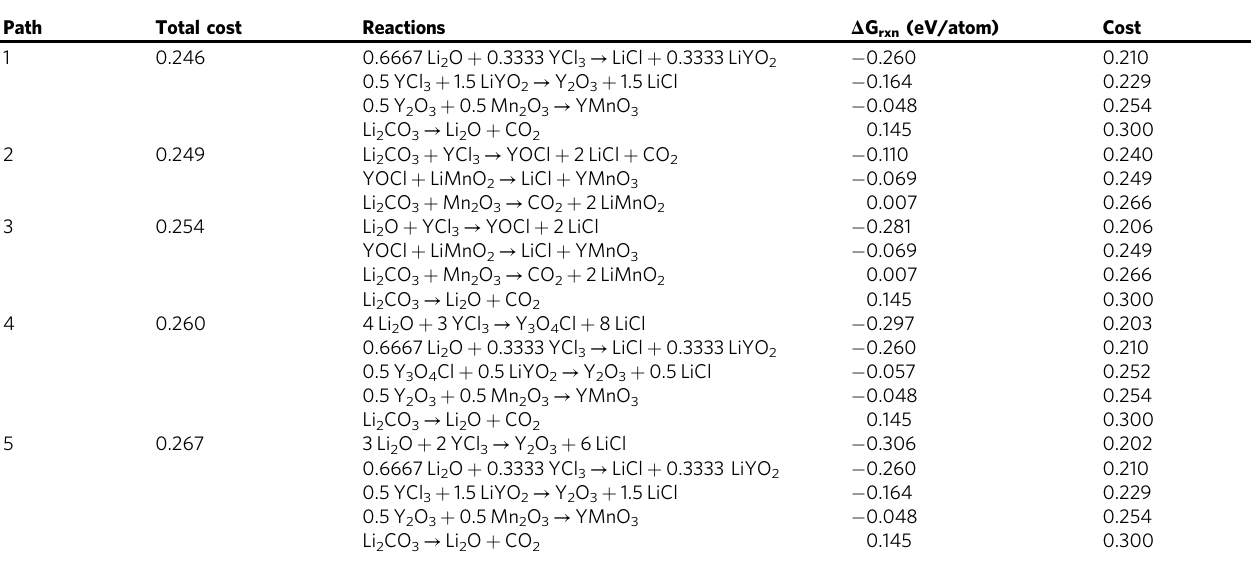
Table 1 Top fi ve predicted reaction pathways to YMnO 3 .